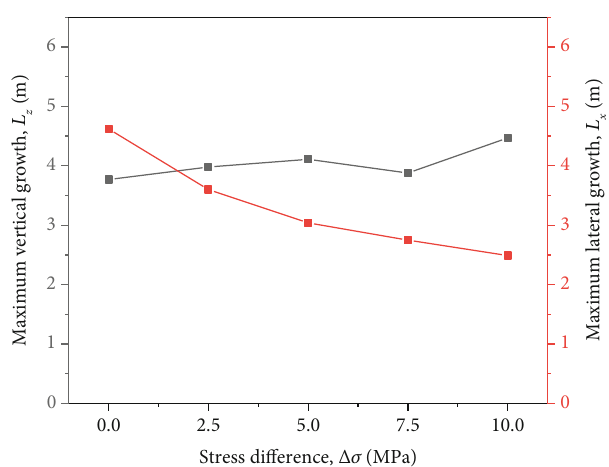
Figure 9: Variations of the maximum vertical growth ( L